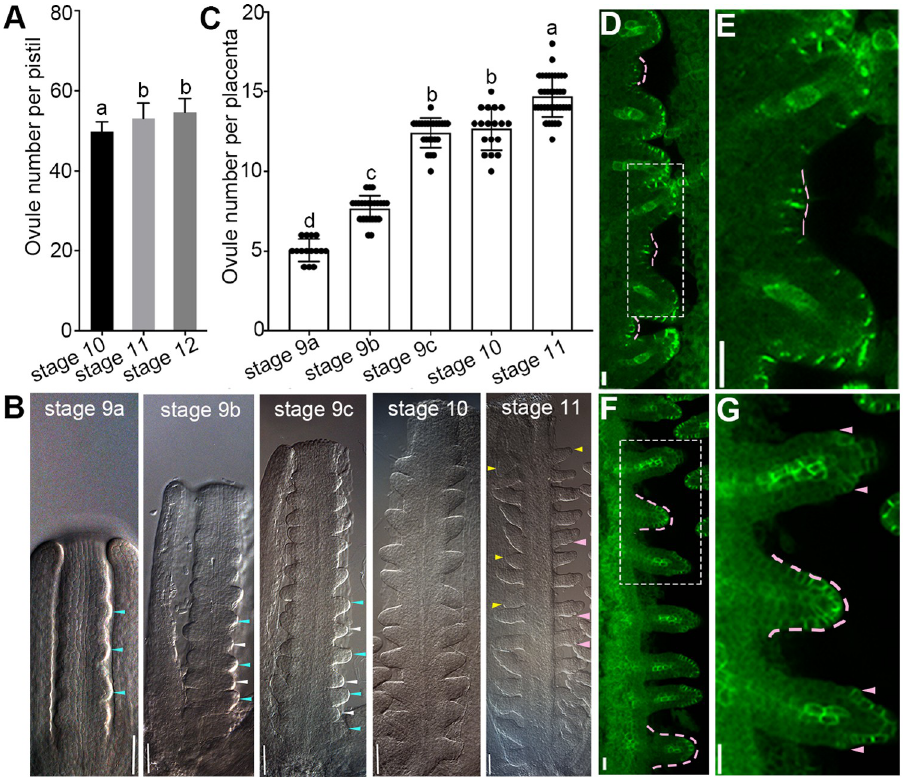
9a-11. (C) Ovule number per placenta. (D-G) Young ovule primordia are indicated by pPIN1 :: PIN1-GFP reporter at floral stage 10 (D-E) and stage 11 (F-G). (E) Magnified view indicated by dashed rectangle in (D) showing young ovule primordia at stage 1-I appearance between existing ovules at stage 2-I. (G) Magnified view indicated by dashed rectangle in (F) displaying young ovule at stage 2-I while adjacent ovules at stage 2-III. Blue and white arrows indicate the first and second group of ovule primordia, respectively (B, stages 9a, 9b, 9c). Yellow arrows (B, stage 11) and pink dashed lines (D-G) indicate the young ovules. Pink arrows indicate the integument primordia (B,G). Data are presented as the mean ± SD (n = 15). Lowercase letters indicate the significant differences revealed by one-way ANOVA (P < 0.05). Bars: 20 μ m (B) and 10 μ m